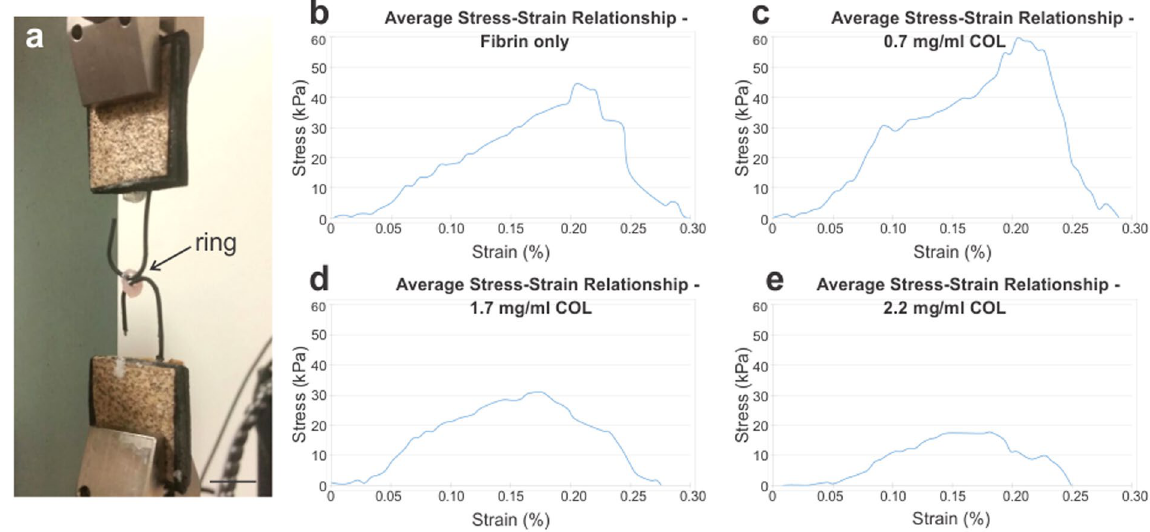
Figure 3. Adventitia rings with 0.7 mg/ml collagen exhibited highest tensile properties. ( a ) Tensile testing setup for the adventitia rings. Average stress-strain curves for ( b ) Fibrin only (n = 20); ( c ) 0.7 mg/ml COL (n = 17); ( d ) 1.7 mg/ml COL (n = 13); and ( e ) 2.2 mg/ml COL (n = 5) rings. The 0.7 mg/ml COL rings exhibited the highest tensile strength. Scale bar = 5 mm.